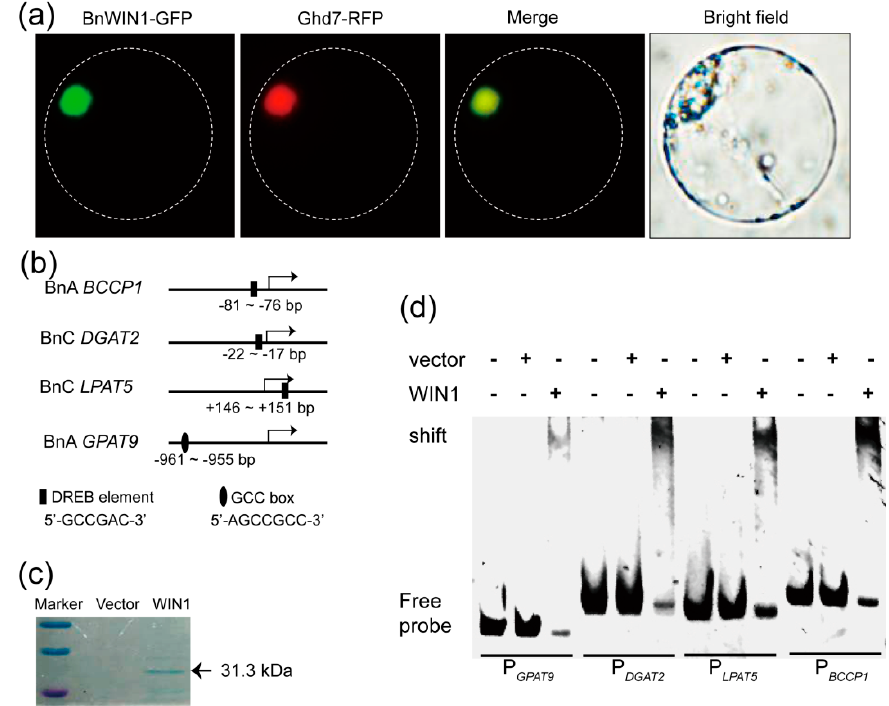
Figure 7. BnWIN1 bound to the promoter region of genes involved in lipid anabolism. ( a ) Nuclear localization of BnWIN1-GFP using BnWIN1-GFP transiently expressed in Arabidopsis protoplasts. Green fluorescence signal of BnWIN1-GFP was overlaid with nuclear red fluorescence (RFP) of the nuclear marker Ghd7-RFP. ( b ) Schematic representation of the cis-elements in promoter regions of target genes. ( c ) Purified recombinant BnWIN1 protein expressed in E. coli cells separated by SDS-PAGE gel and stained with Coomassie blue. ( d ) Electrophoretic mobility-shift assay of BnWIN1 binding to the promoter region of GPAT9 , DGAT2 , LPAT5 , and BCCP1 containing GCC-box or DREB element.